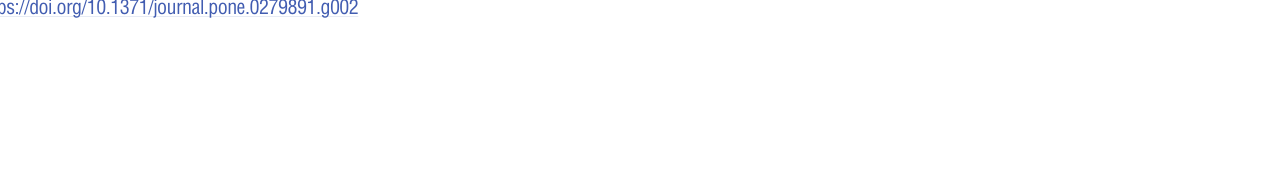
PLOS ONE | https://doi.org/10.1371/journal.pone.0279891 January 18,